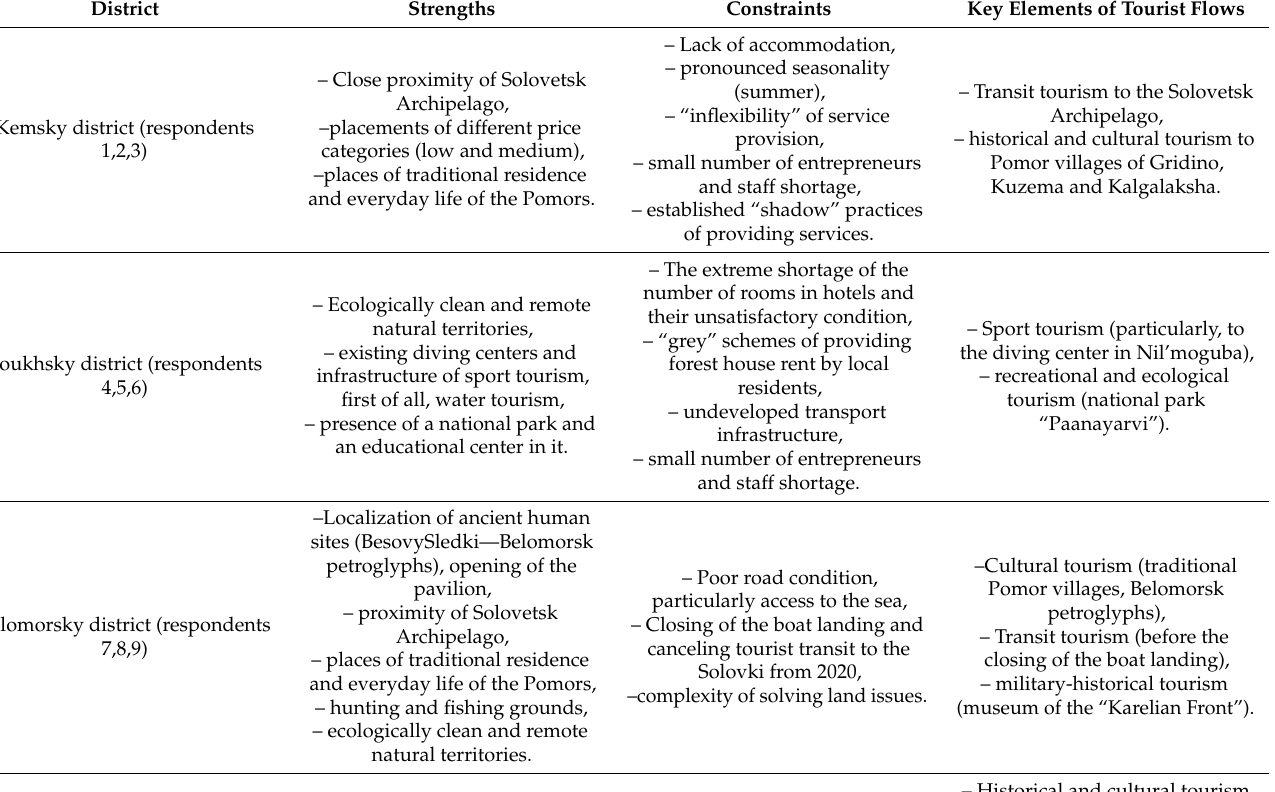
Table 3. Qualitative features of the tourist potential of the territories of the Karelian Arctic.